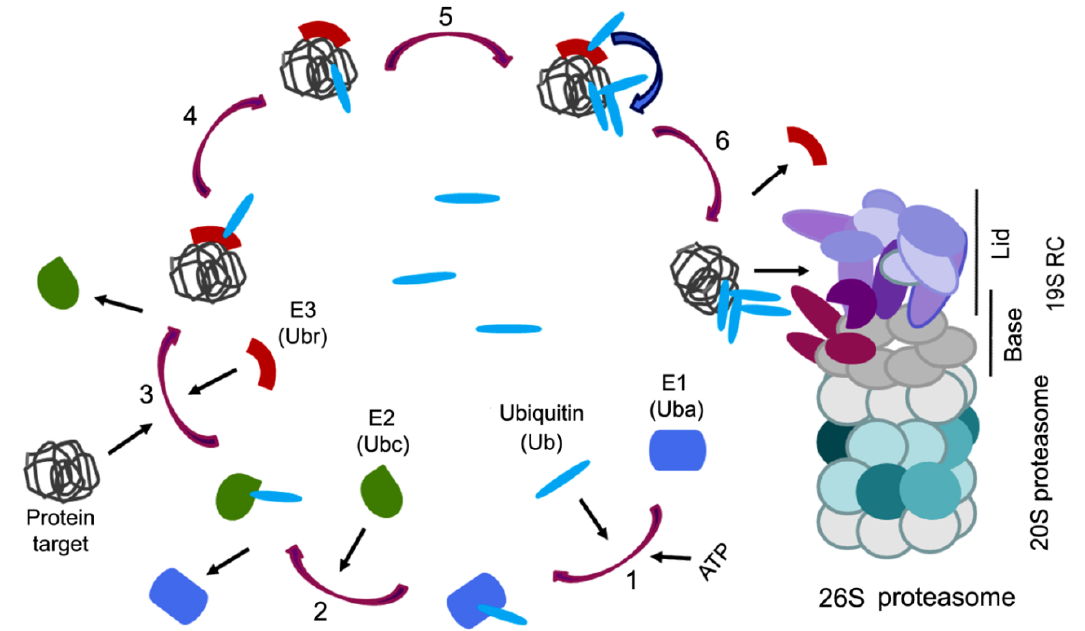
Figure 2. The canonical pathway of protein ubiquitination for degradation in the 26S proteasome. 1: ATP-dependent activation of the ubiquitin (Ub) by ubiquitin-activating enzyme (Uba). 2: Transfer of the activated ubiquitin to ubiquitin-conjugating enzyme (Ubc). 3: Binding of ubiquitin–protein ligase (ubiquitin-recognizing factor, Ubr), containing the homologous to E6AP carboxyl terminus (HECT) domain, to the ubiquitin and target protein. 4: Covalent attachment of the ubiquitin molecule to the target protein. 5: Building of the ubiquitin chain with the formation of isopeptide bonds Lys48-Gly76. 6: Completion of the labeling of the target protein with a structure of four (or more) ubiquitin molecules recognized by the 26S proteasome.